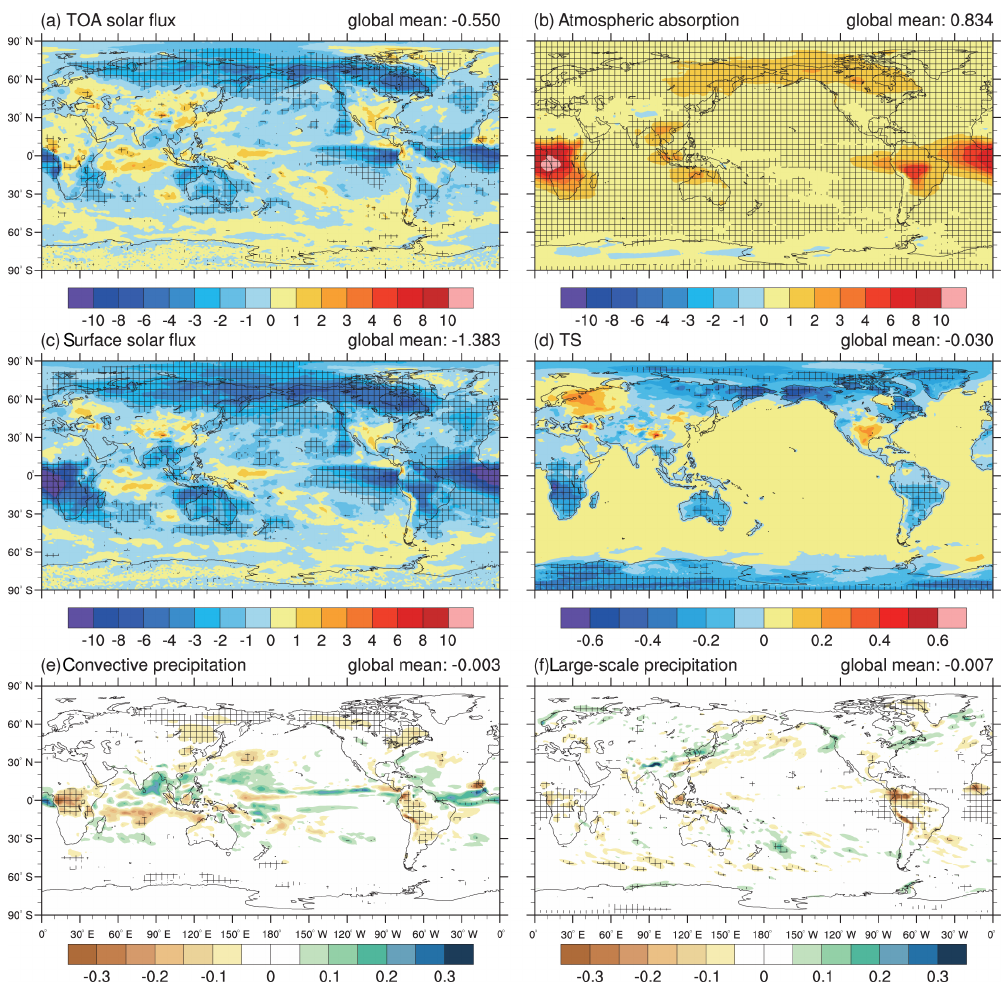
Figure 11. Annual mean net shortwave flux changes (Wm − 2 ) over the period of 2003–2011 (a) at top of the atmosphere, (b) in the at- mosphere, (c) at the surface and changes of (d) surface air temperature ( T s , K), (e) convective precipitation (mmd − 1 ) and (f) large-scale precipitation (mm d − 1 ) due to all fire aerosols. The plus signs denote the regions where the change is statistically significant at the 0.1